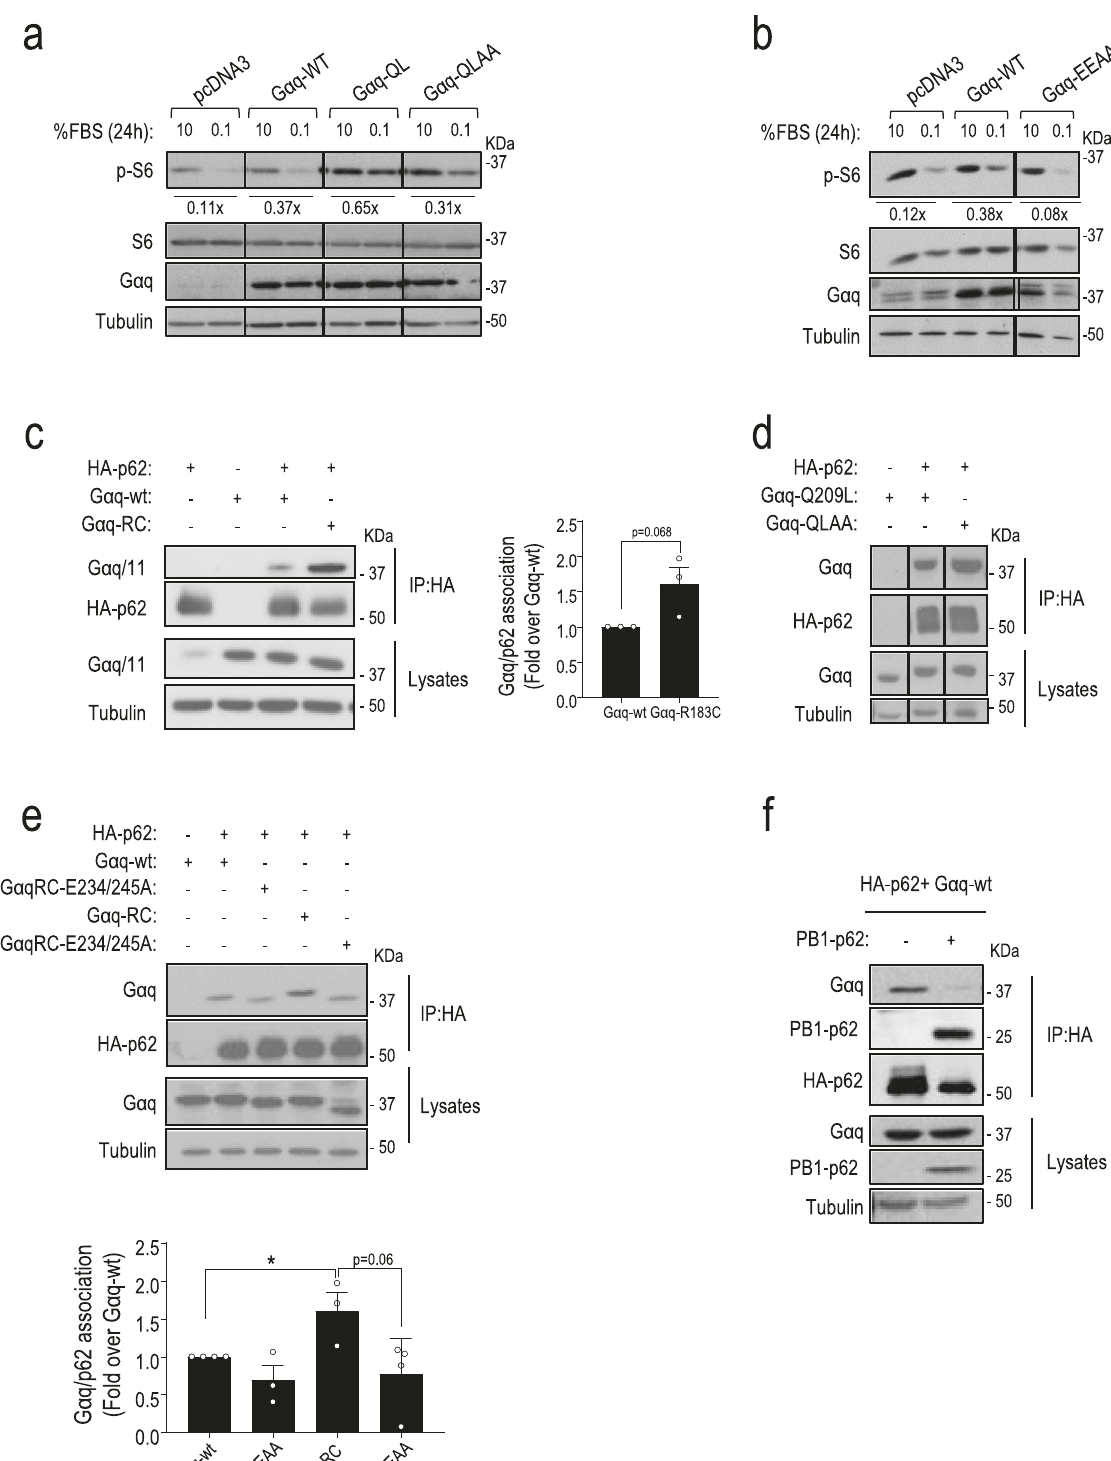
While G α q/11 KO + Gq MEFs recovered the basal mTORC1 activation status of WT MEFs, cells displaying decreased G α q/p62 interaction ( + G α q-EEAA MEFs) showed a pattern similar to parental G α q/11 KO MEFs with signi fi cantly lower mTORC1 pathway activation and, consistently, enhanced autophagy, as indicated by higher LC3-II protein levels (Fig. 7c). Consistently, analysis of endogenous mTOR complexes showed a decreased